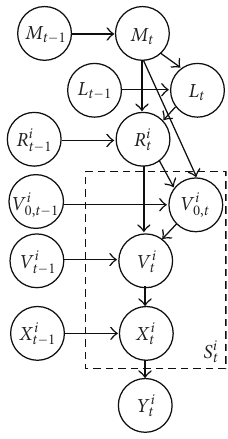
Figure 8: Expanded DAG for single feature displaying the